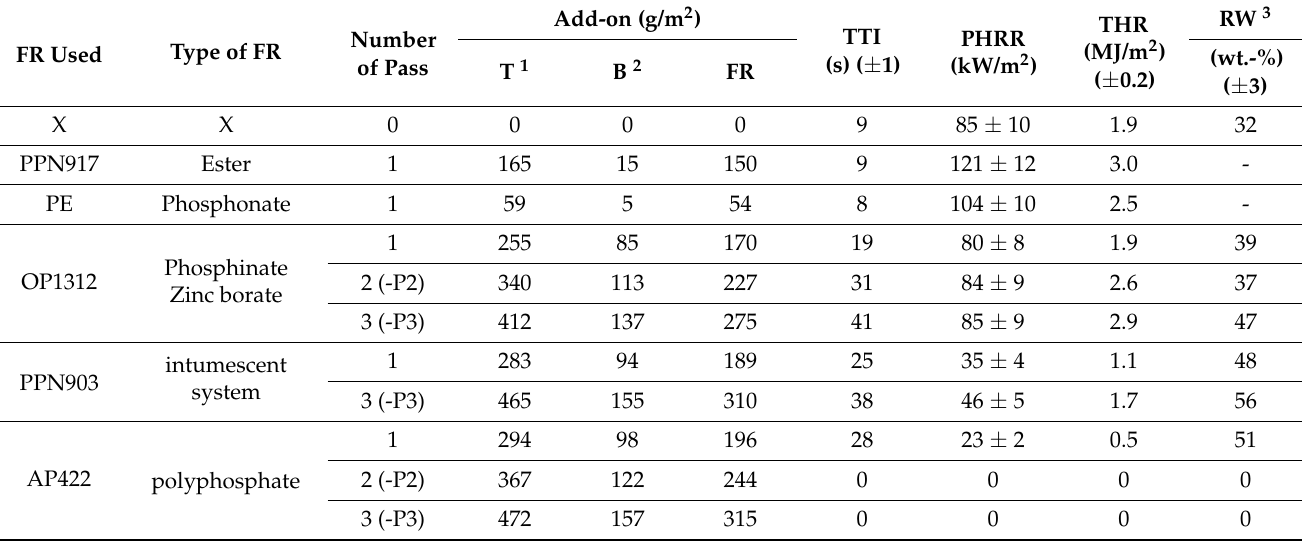
Table 2. Cone calorimeter performance of FR-treated